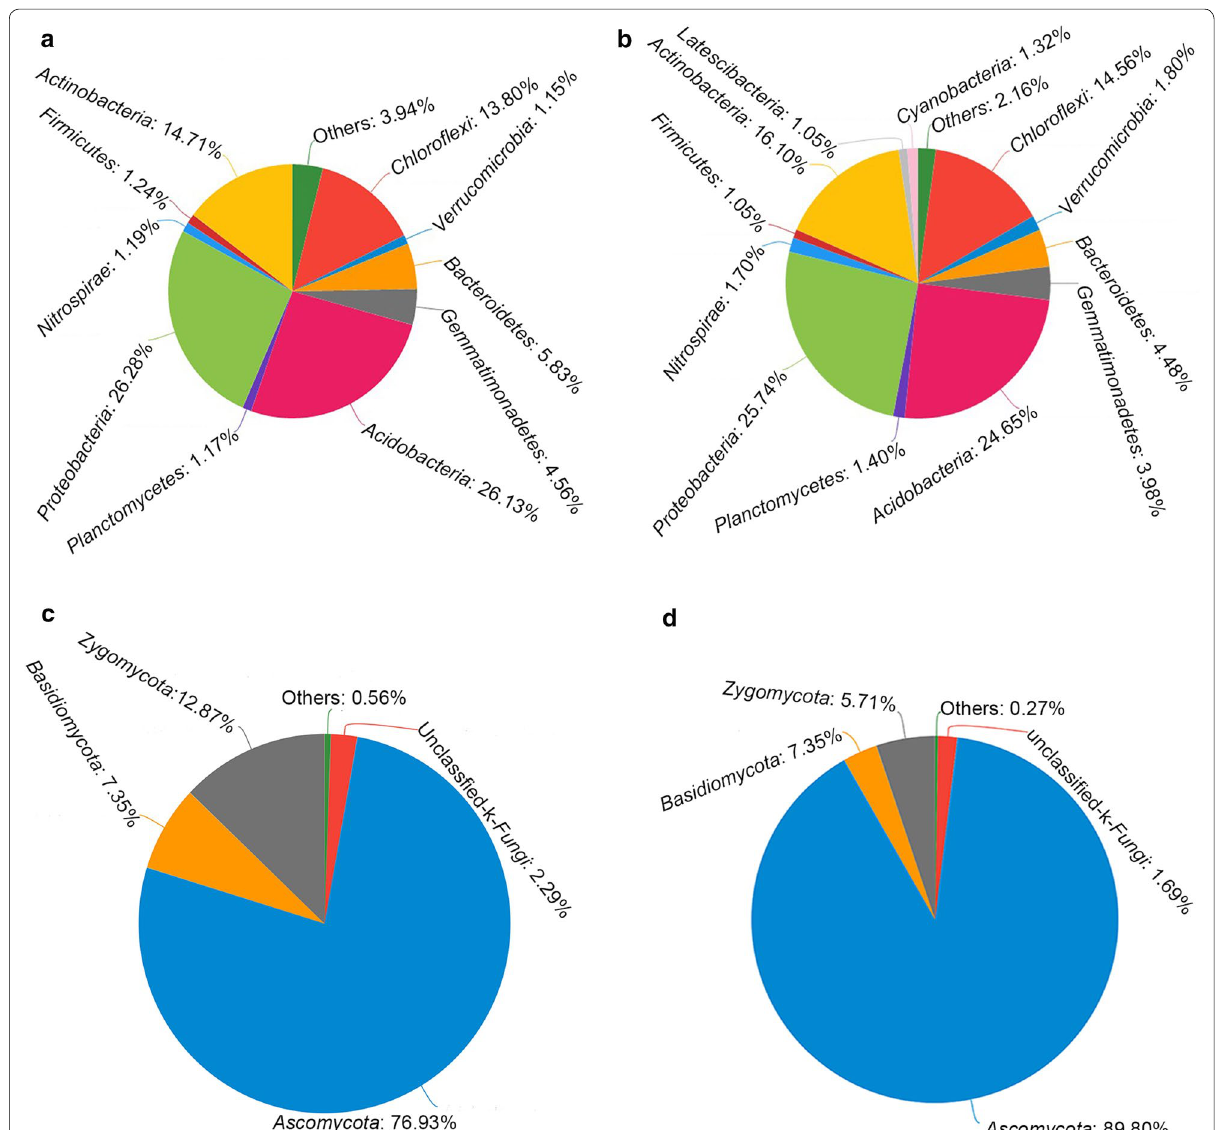
Fig. 4 Relative abundance of the dominant bacterial and fungal phyla in CS-1 and control treatment. The relative abundance (%) of all bacteria and fungi on the phylum level in the rhizosphere soil of CS-1 and control treatments. a The relative abundance of all detected bacterial phyla after the control treatment. b The relative abundance of all detected bacterial phyla after the CS-1 treatment. c The relative abundance of all detected fungal phyla control treatment. d The relative abundance of all detected fungal phyla after the CS-1